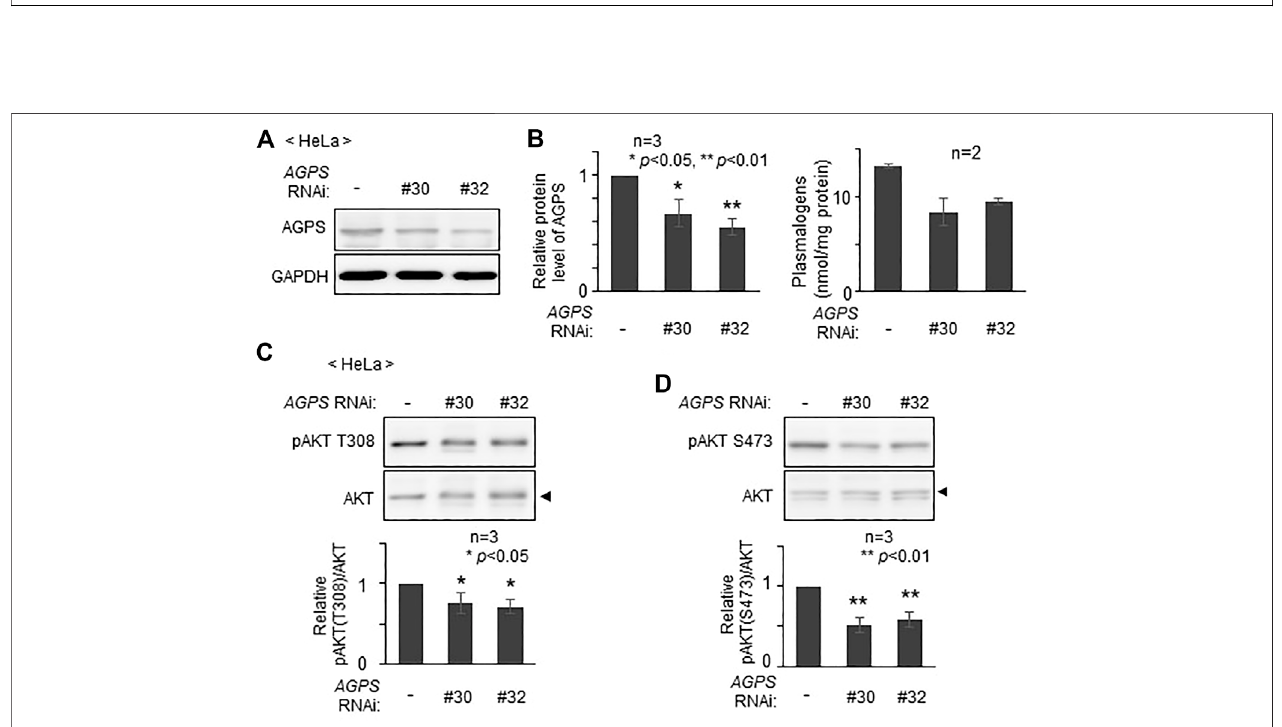
FIGURE 3 | Reduction of AKT activity by lowering plasmalogens. (A) HeLa cells were transfected with two different dsRNAs (#30 and #32) against AGPS and cultured for 72 h. Protein level of AGPS was analyzed by immunoblotting. GAPDH was used as a loading control. (B) Protein level of AGPS ( left ) and plasmalogen level ( right )wererepresented bytakingasonethatinnon-transfectedHeLacells. (C,D) PhosphorylationofAKTwasanalyzedbyimmunoblottingusingantibodiesspeci fi cfor the phosphorylated T308 (C) and S473 (D) and total unmodi fi ed AKT (arrowhead). The amounts of pAKT T308 (C) and pAKT S473 (D) relative to total AKT were represented( lowerpanels ).Dataindicate means±SD( n =3).* p < 0.05and* p < 0.01,byone-wayANOVAwithDunnett ’ sposthoctestascompared withHeLacells(-).